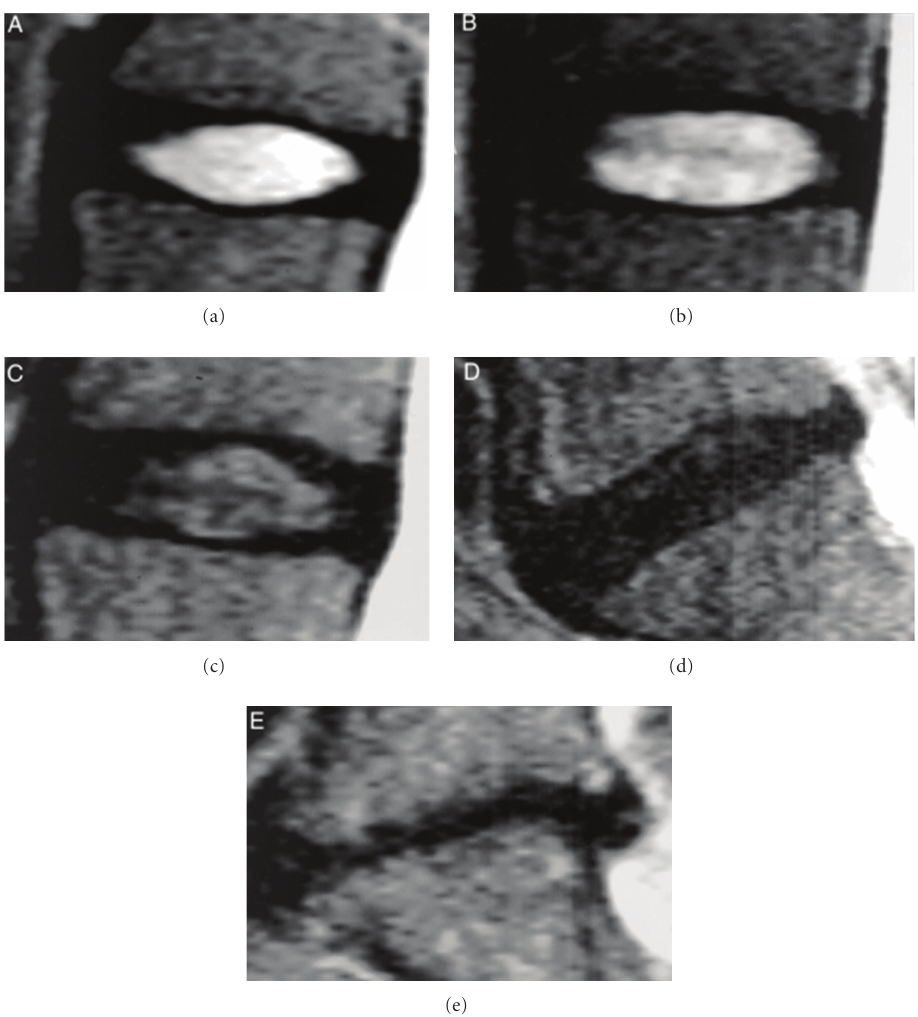
Figure 1: (a–e) pictures depict the grading system for the assessment of lumbar disc degeneration. Grade I: the structure of the disc is homogeneous, with bright hyperintense white signal intensity and a normal disc height. Grade II: the structure of the disc is inhomogeneous, with a hyper intense white signal. The distinction between nucleus and annulus is clear, and the disc height is normal, with or without horizontal gray bands. Grade III: the structure of the disc is inhomogeneous, with intermediate gray signal intensity. The distinction between nucleus and annulus is unclear, and the disc height is normal or slightly decreased. Grade IV: the structure of the disc is inhomogeneous, with hypointense dark gray signal intensity. The distinction between nucleus and annulus is lost, and the disc height is normal or moderately decreased. Grade V: the structure of the disc is inhomogeneous, with hypo intense black signal intensity. The distinction between nucleus and annulus is lost, and the disc space is collapsed. Grading is performed on T2-weighted midsagittal (repetition time 5000 msec/echo time 130msec) fast spin-echo images